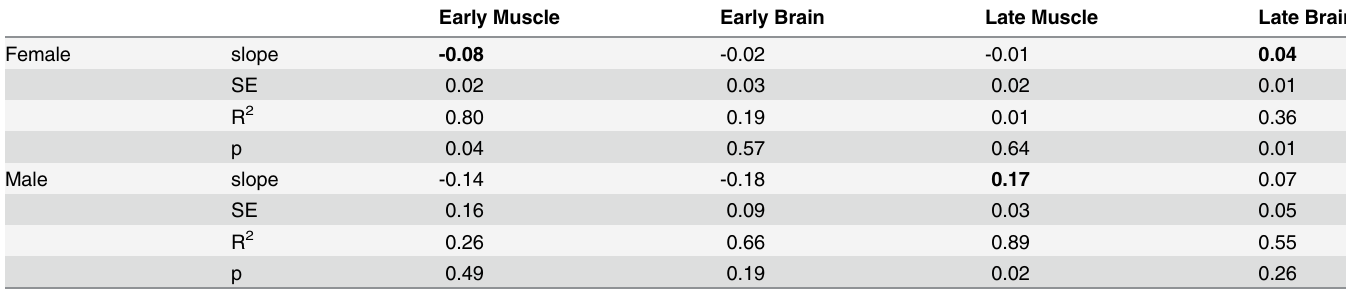
Table 3. The regression statistics of RTL on final length and dry gonad mass separated by tissue and gender.